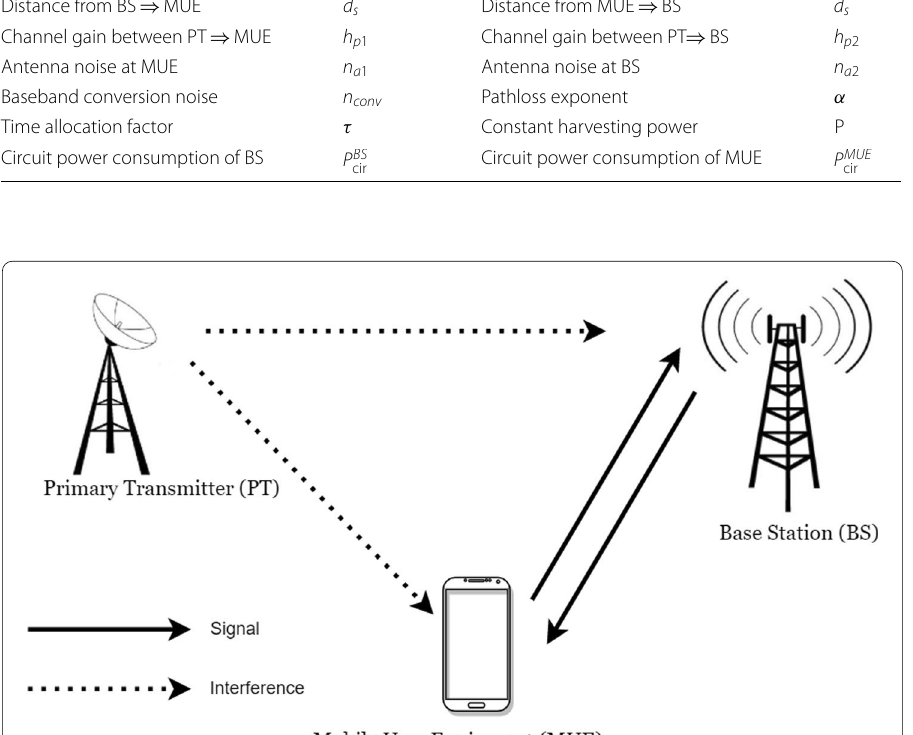
Fig. 1 A CR network model where MUE communicates bidirectionally with BS. Also, MUE and BS receive a interference signal from